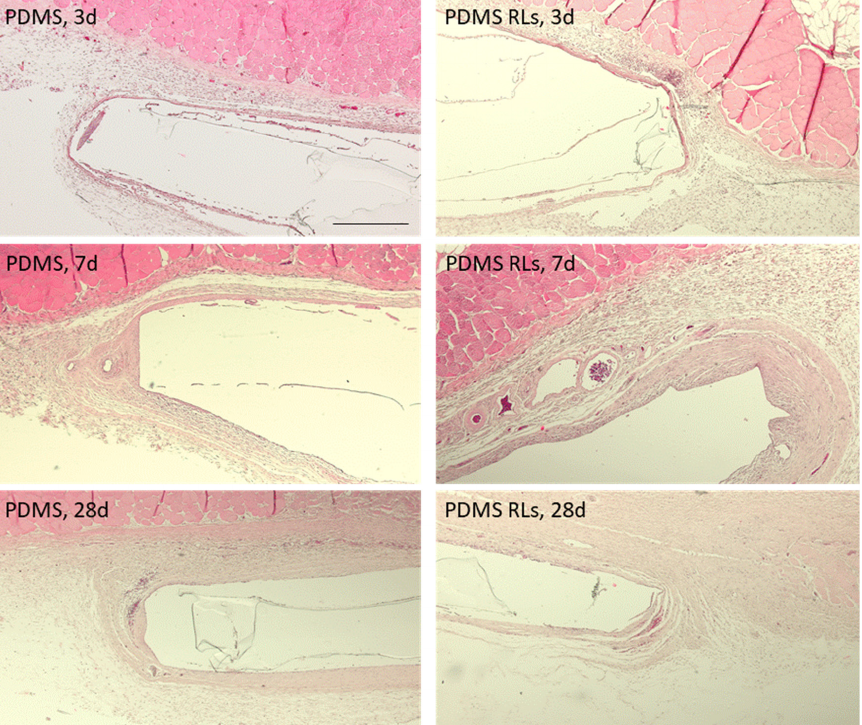
Figure 7. Representative photomicrographs of the histological tissue sections following PDMS and PDMS–RLs implantation, at 3, 7 and 28 days, stained with hematoxylin and eosin. Scale bar: 150 µm.